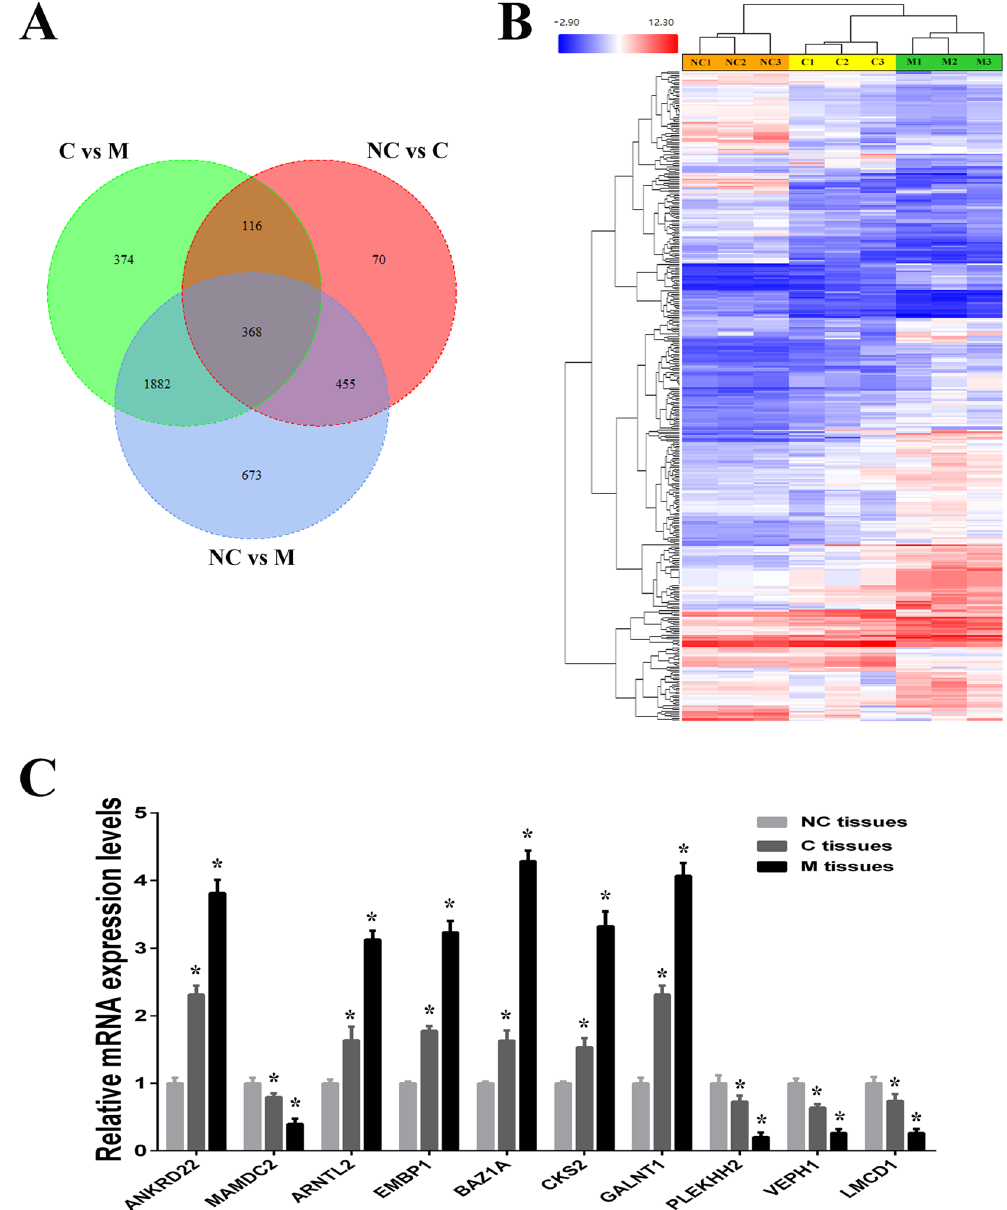
Figure 1. Gene expression profile analysis of NC, C and M tissues in NSCLC. ( A ) Venn diagram showing the overlap in differentially expressed genes in three comparisons between NC, C and M tissues. ( B ) Clustering of successively changed genes in NC, C and M tissues. Color corresponds to the expression levels of genes according to the color bar scale. ( C ) Expression levels of 10 candidate genes in 3 pairs of NSCLC samples (NC, C and M tissues) were measured by RT-PCR. NC, adjacent carcinoma tissues; C, primary carcinoma tissues; M, metastatic carcinoma tissues. (n = 3, * P <